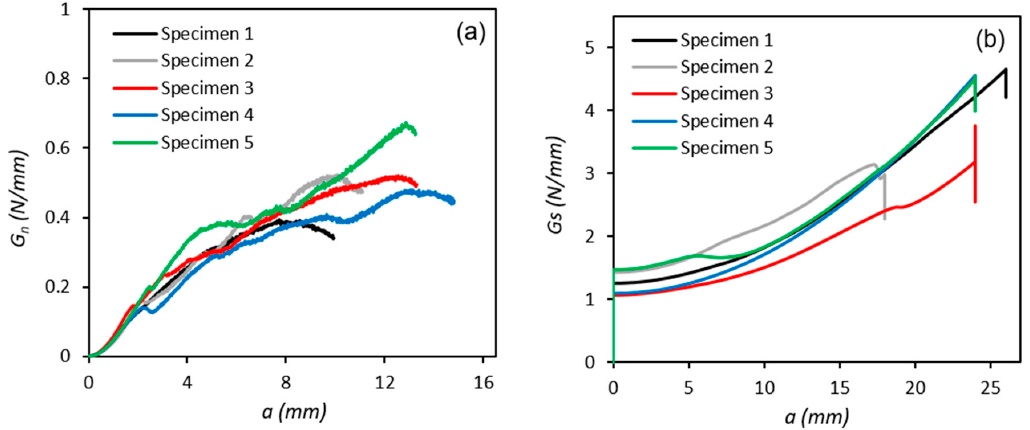
Figure 7. Fracture energy curves for ( a ) DCB and ( b ) ENF tests.